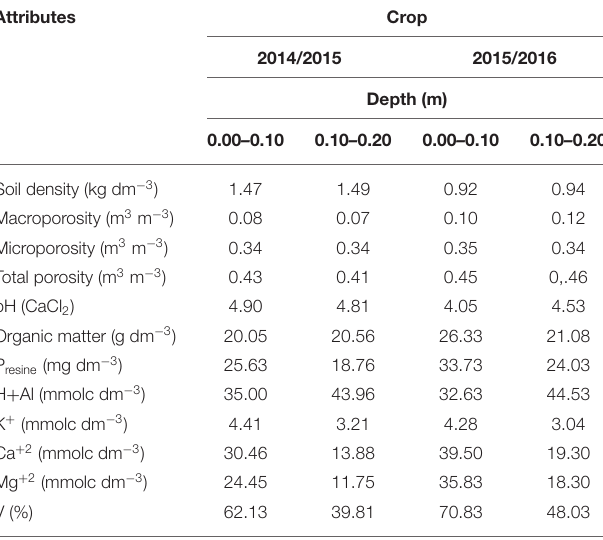
TABLE 2 | Soil physical and chemical attributes at 0.00 – 0.10 and 0.10 – 0.20m depths in 2014/2015 and 2015/2016 crops.